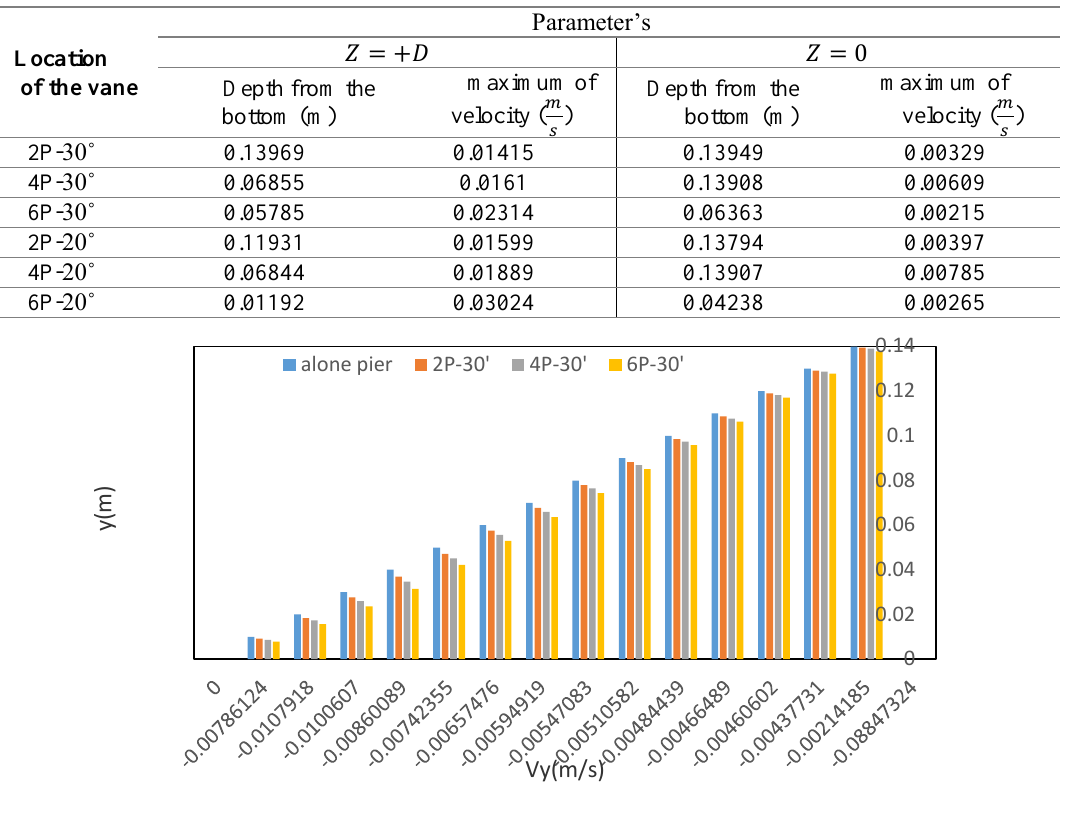
Fig 17. Comparison of the vertical velocity component for 𝛼 = 30˚ , 𝑍 =